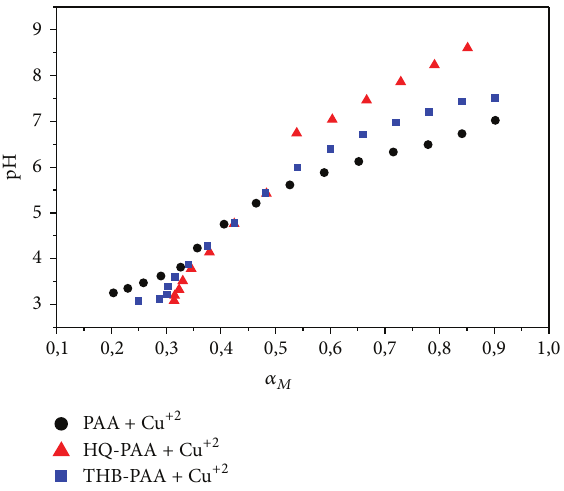
Figure 6: Plots of pH = f (𝛼 𝑀 ) for PAA/Cu(II) and HQ- PAA/Cu(II). [NaNO 3 ] = 0.01mol/L. The curve in blue square is for tetrahydroxybenzene-polyacrylic acid (THB-PAA) in the presence of copper (II) and [NaNO 3 ] = 0.01 mol/L